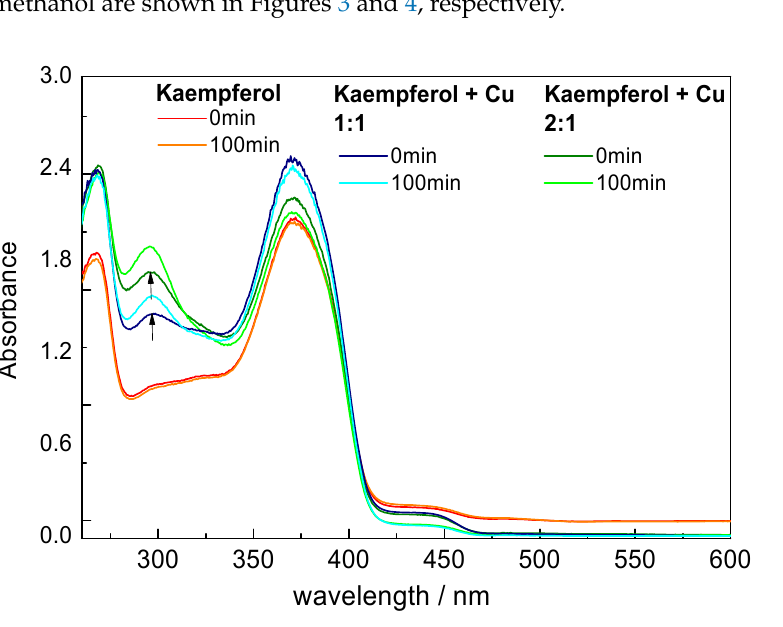
Figure 3. UV-vis spectra of kaempferol and its Cu(II) complexes (1:1 and 1:2) in DMSO. [Cu(II)] = 0.1 mM. The spectra were recorded 5 min after mixing of the copper solution with kaempferol.